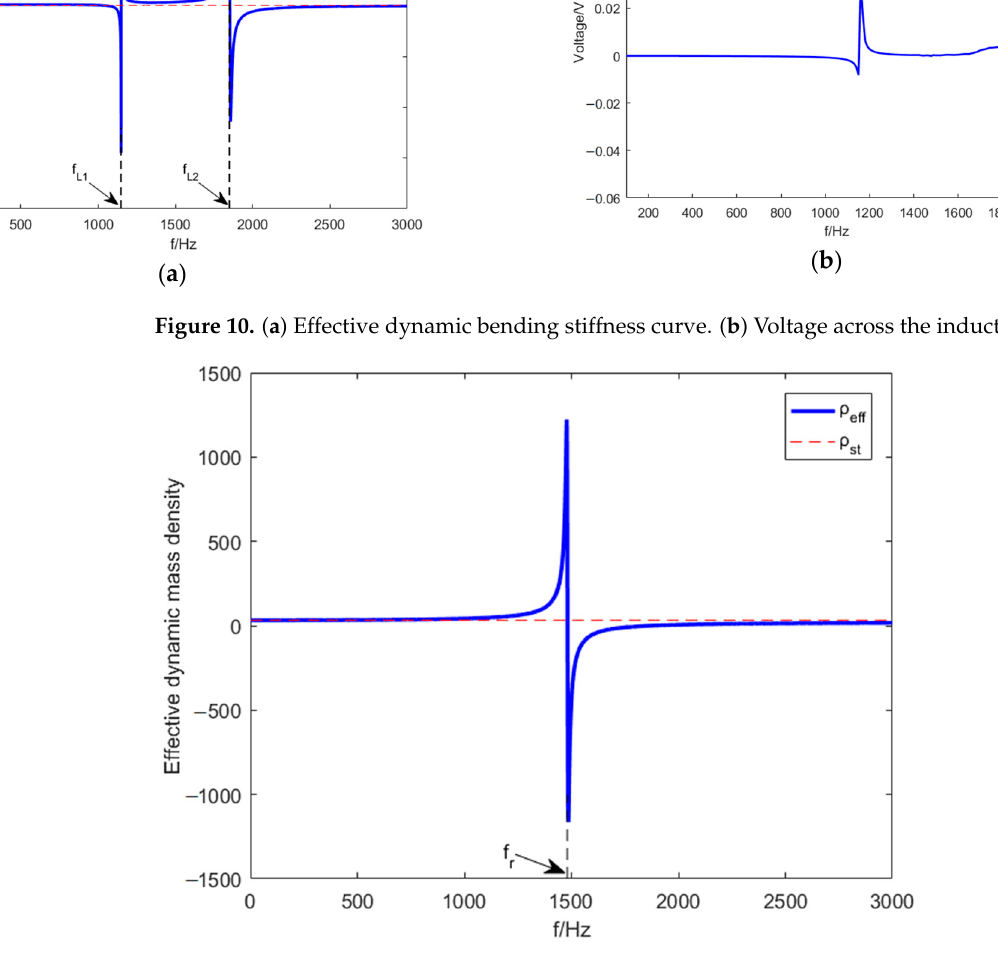
Figure 11. Effective dynamic mass–density curve.